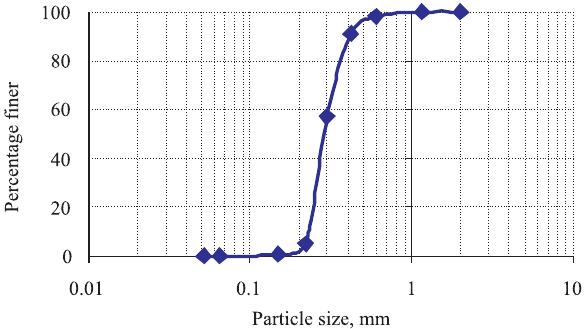
Fig. 1. Size distribution of Klaipėda sand